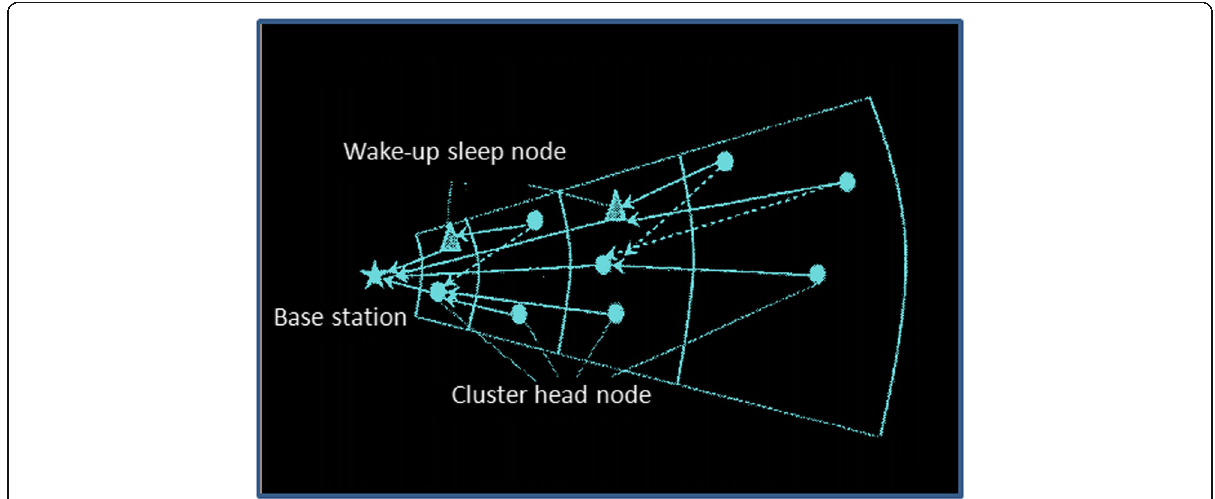
Fig. 4 Schematic diagram of intra-clusters multi-hop of four-layer and two-hop